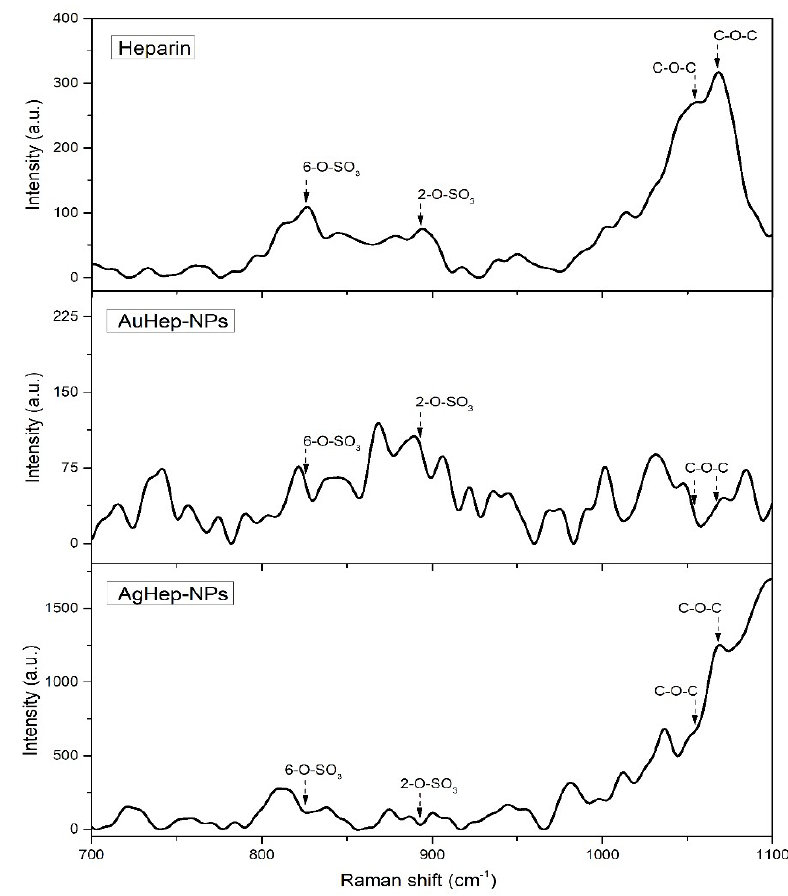
Figure 3. Raman spectra of heparin and those of AuHep-NPs and AgHep-NPs.